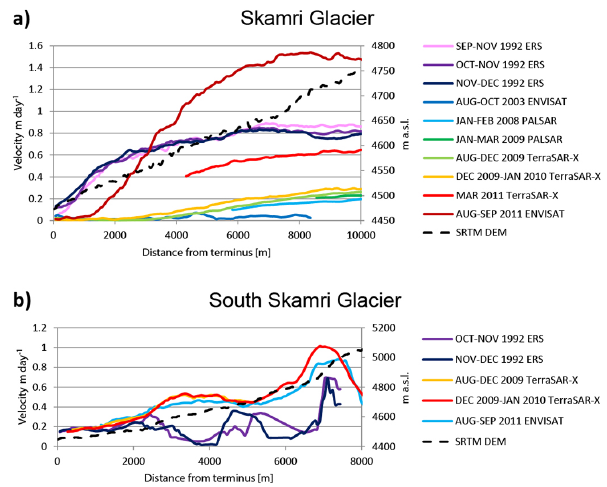
Figure 8. Velocity profiles along the centerlines of the Skamri (a) and South Skamri glaciers (b) . The location of the centerline pro- files is marked in Fig.